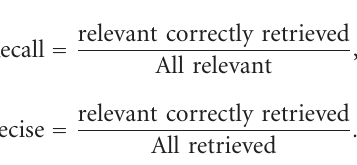
rate (recall) and check rate (precision) to evaluate [17,